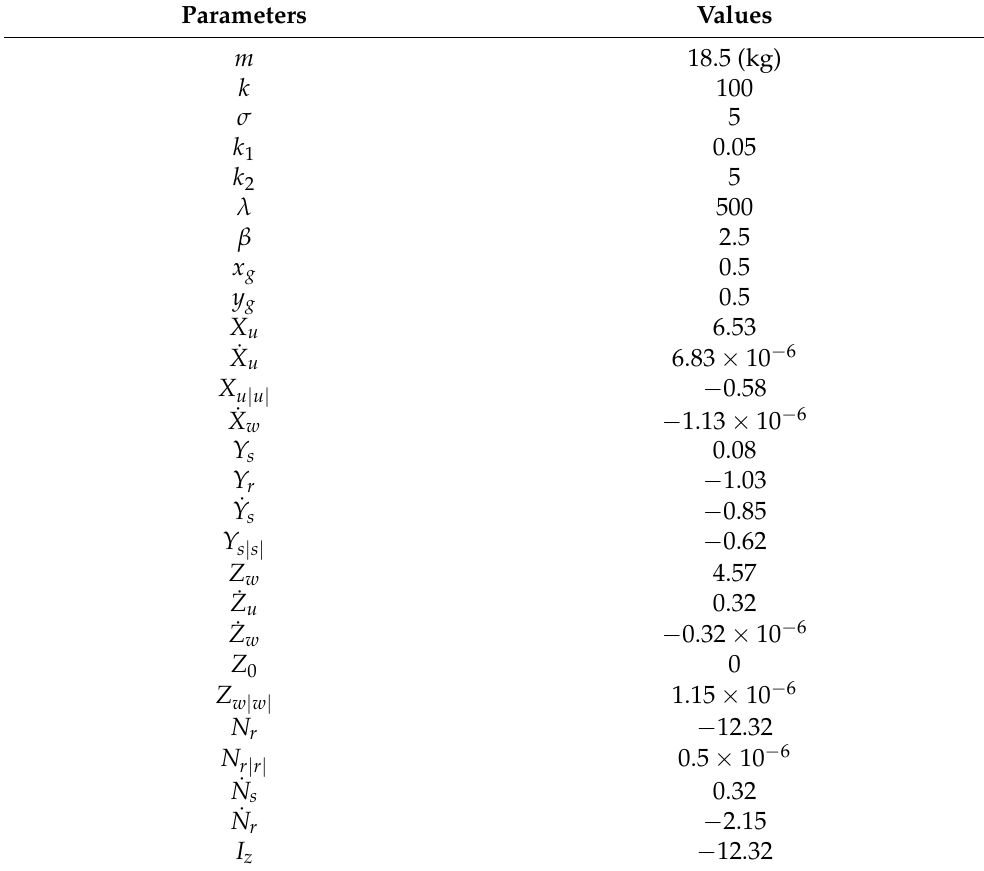
Table 2. The parameters of AUV system.